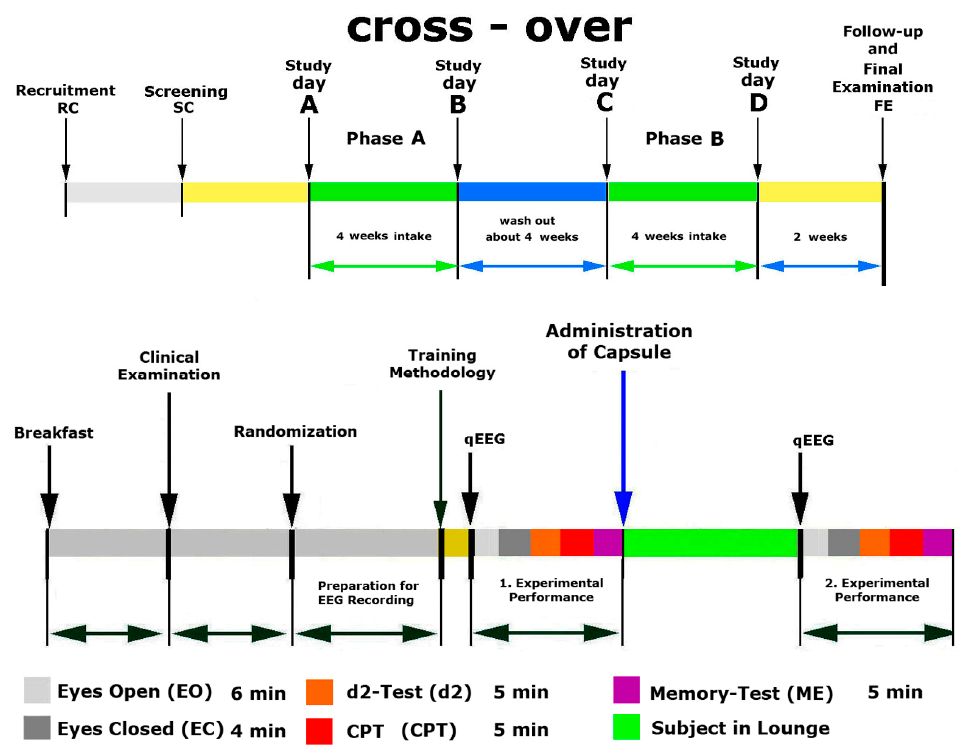
Figure 7. Design and timeline of the study days A, B, C, D, and FU. Performance: eyes open (Eo), eyes closed (Ec) and different cognitive tests: attention test (d2-Test), memory test (ME-Test), and concentration performance test (CPT ).